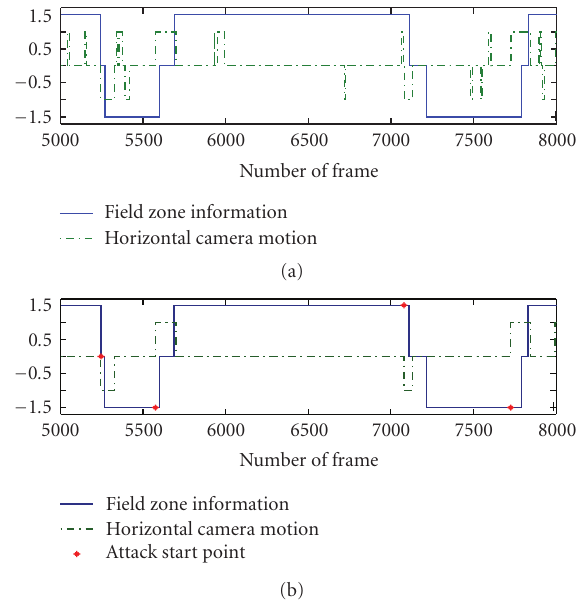
Figure 2: Attack-based sports video segmentation. (a) Initial field zone and horizontal camera motion information. (b) Smoothed horizontal camera motion and three attack segments (#1: 5210– 5613; #2: 5613–7120; #3: 7120–7748).